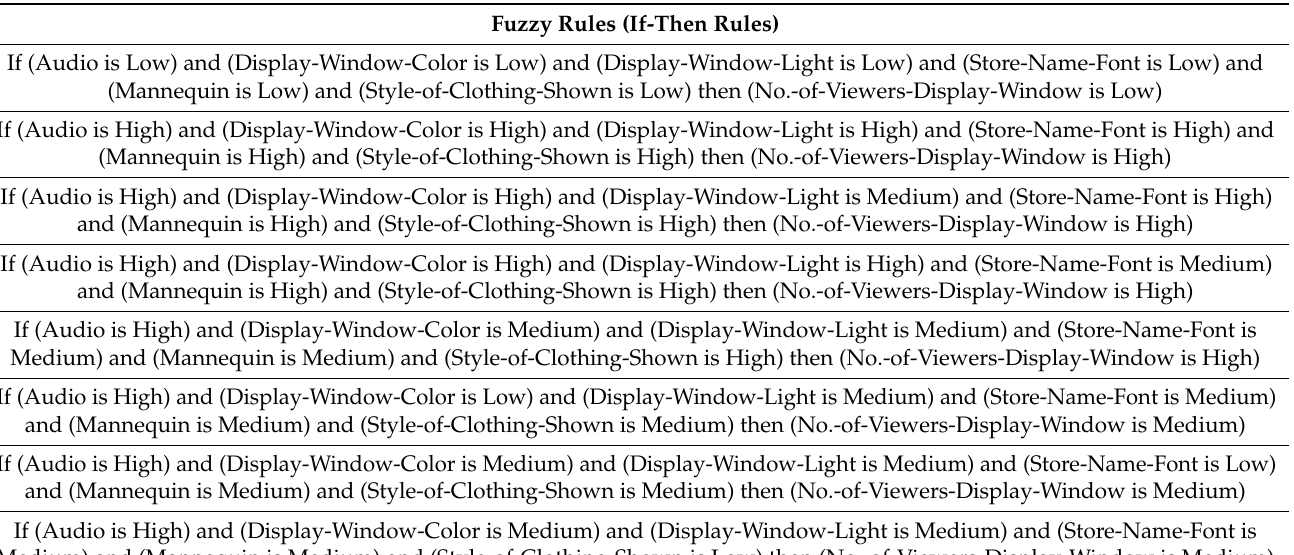
Table 3. Fuzzy systems’ if–then rules. Fuzzy Rules (If-Then Rules)